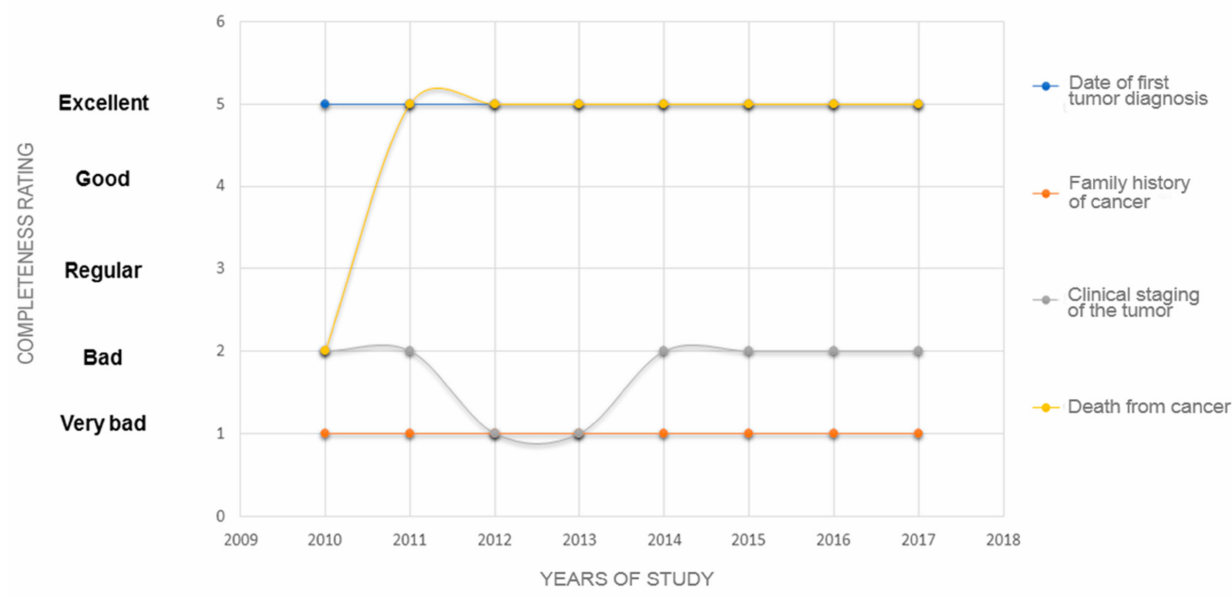
Figure 2. Trends in the completeness of the clinical variables: date of first tumor diagnosis, family history of cancer, clinical staging of the tumor, and death from cancer of HCR between 2010 and 2017. Vit ó ria, ES, 2020.